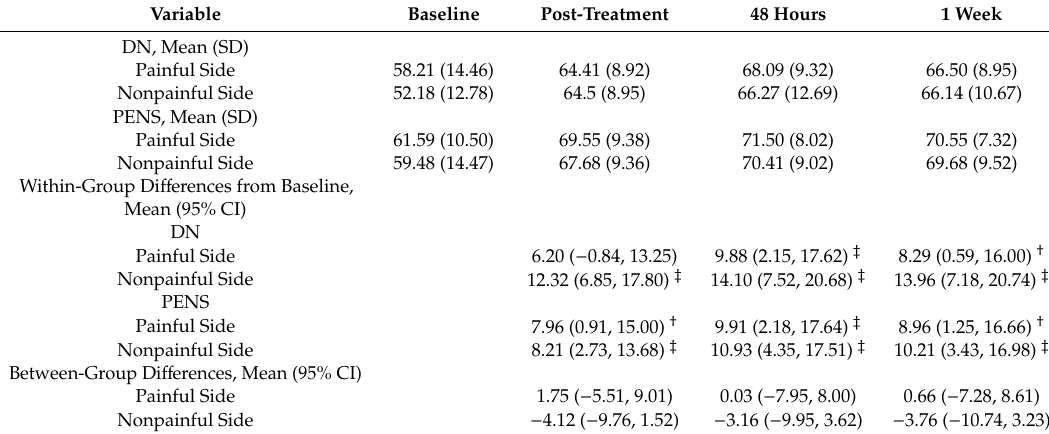
Table 5. Cervical rotation range of movement di ff erences within- and between-group. Variable